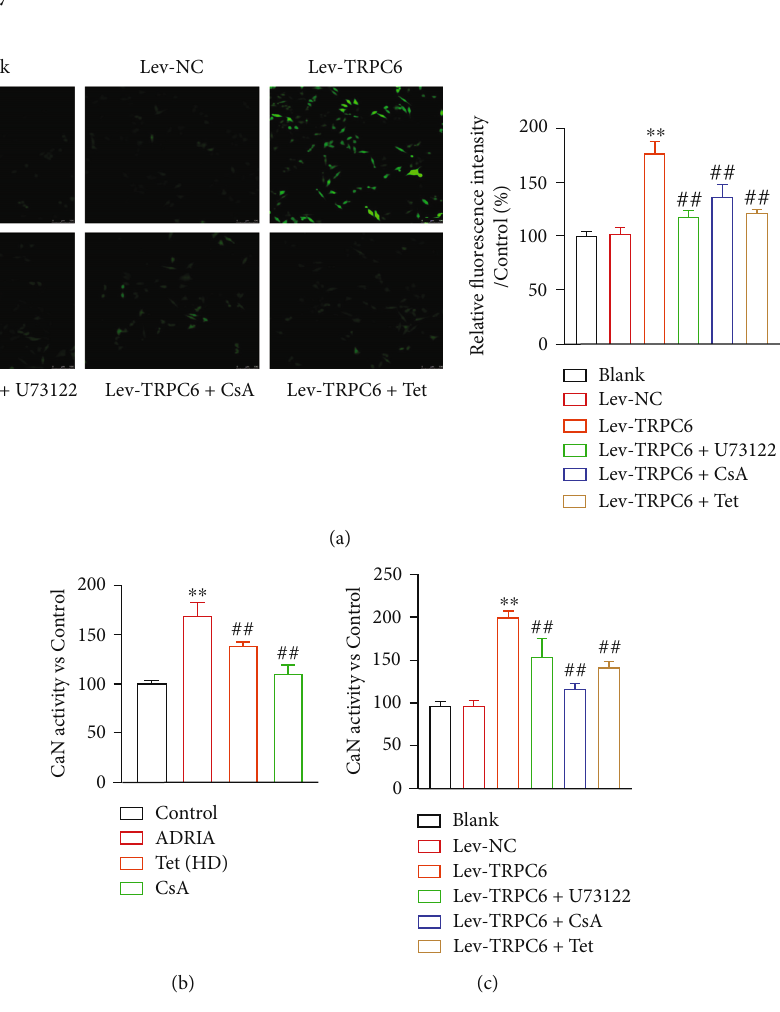
Figure 4: Tetrandrine (Tet) reduced intracellular Ca 2+ in fl ux and calcineurin (CaN) activity in vitro and in vivo . (a) The intracellular Ca 2+ in fl ux in MPC5 podocytes was identi fi ed by fl uorescence detection ( scalebar = 100 μ m). ∗∗ P < 0 : 01 versus the lev-NC group. ## P < 0 : 01 versus the lev-TRPC6 group. (b, c) The CaN activities in rats and in MPC5 podocytes. ∗∗ P < 0 : 01 versus the control or lev-NC group. ## P < 0 : 01 versus the ADRIA or lev-TRPC6 group. Nephropathy rats were induced by adriamycin (ADRIA) and then treated with high- dose Tet (16 mg/kg/d) or cyclosporine A (CsA, a positive drug). MPC5 podocytes were transfected with lev-NC or lev-TRPC6 and then treated with U73122 (an inhibitor of TRPC6 channel opening), CsA, or